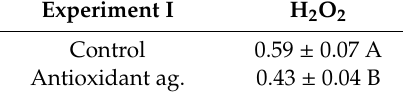
Figure 4. Hydrogen peroxide ( A ) and superoxide production ( B ), membrane damage in the first experiment ( C ) and the second experiment ( D ), malondialdehyde content in the first experiment ( E ) and the second experiment ( F ) in soybean plants under different soil water potentials and xenobiotic and antioxidant agent application. Note: asterisks indicate error probability as * = 10%, ** = 5%, and *** = 1%, respectively. Vertical bars represent the standard error of the samples. Analysis of hydrogen peroxide and membrane damage in the first experiment was made with transformed data. Hydrogen peroxide data were transformed by square root, and membrane damage data were transformed by a logarithmic function. Table 7. Hydrogen peroxide ( µ mol mg protein − 1 ) in soybean plants submitted to antioxidant Table 8. Superoxide (mmol protein − 1 min − 1 ) in soybean plants submitted to xenobiotic and antioxidant agent application.